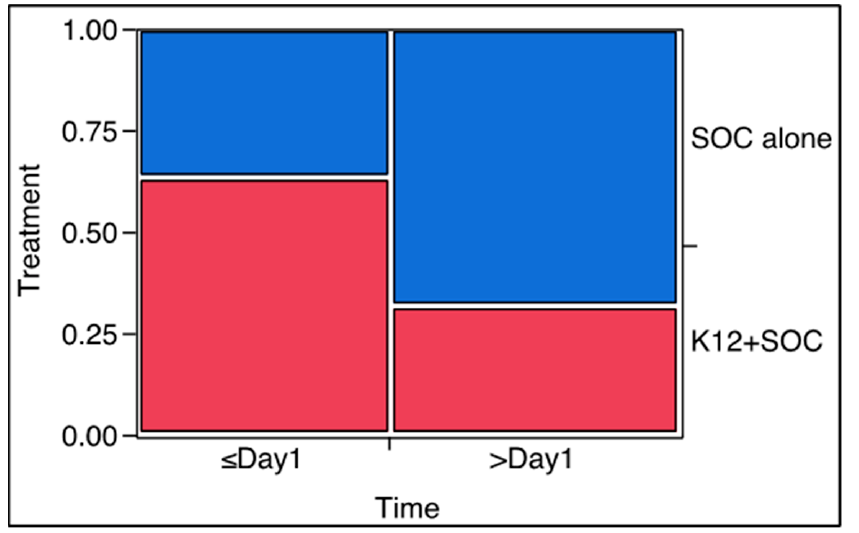
Figure 2. Patient proportion that demonstrates improvement ( ≤ Day 1) or worsening ( ≥ Day 1) of Ferritin according to the possible treatment (in blue, standard of care; in red, standard of care plus S. salivarius K12).